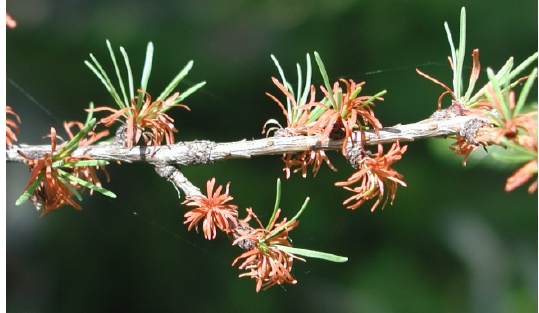
Figure 7. Juvenile needles of Siberian larch that have suffered from a cold wind. This type of abiotic injury is often only on one side of the canopy or even on a small part of it. Kivalo Research Area, 2 July 2006.